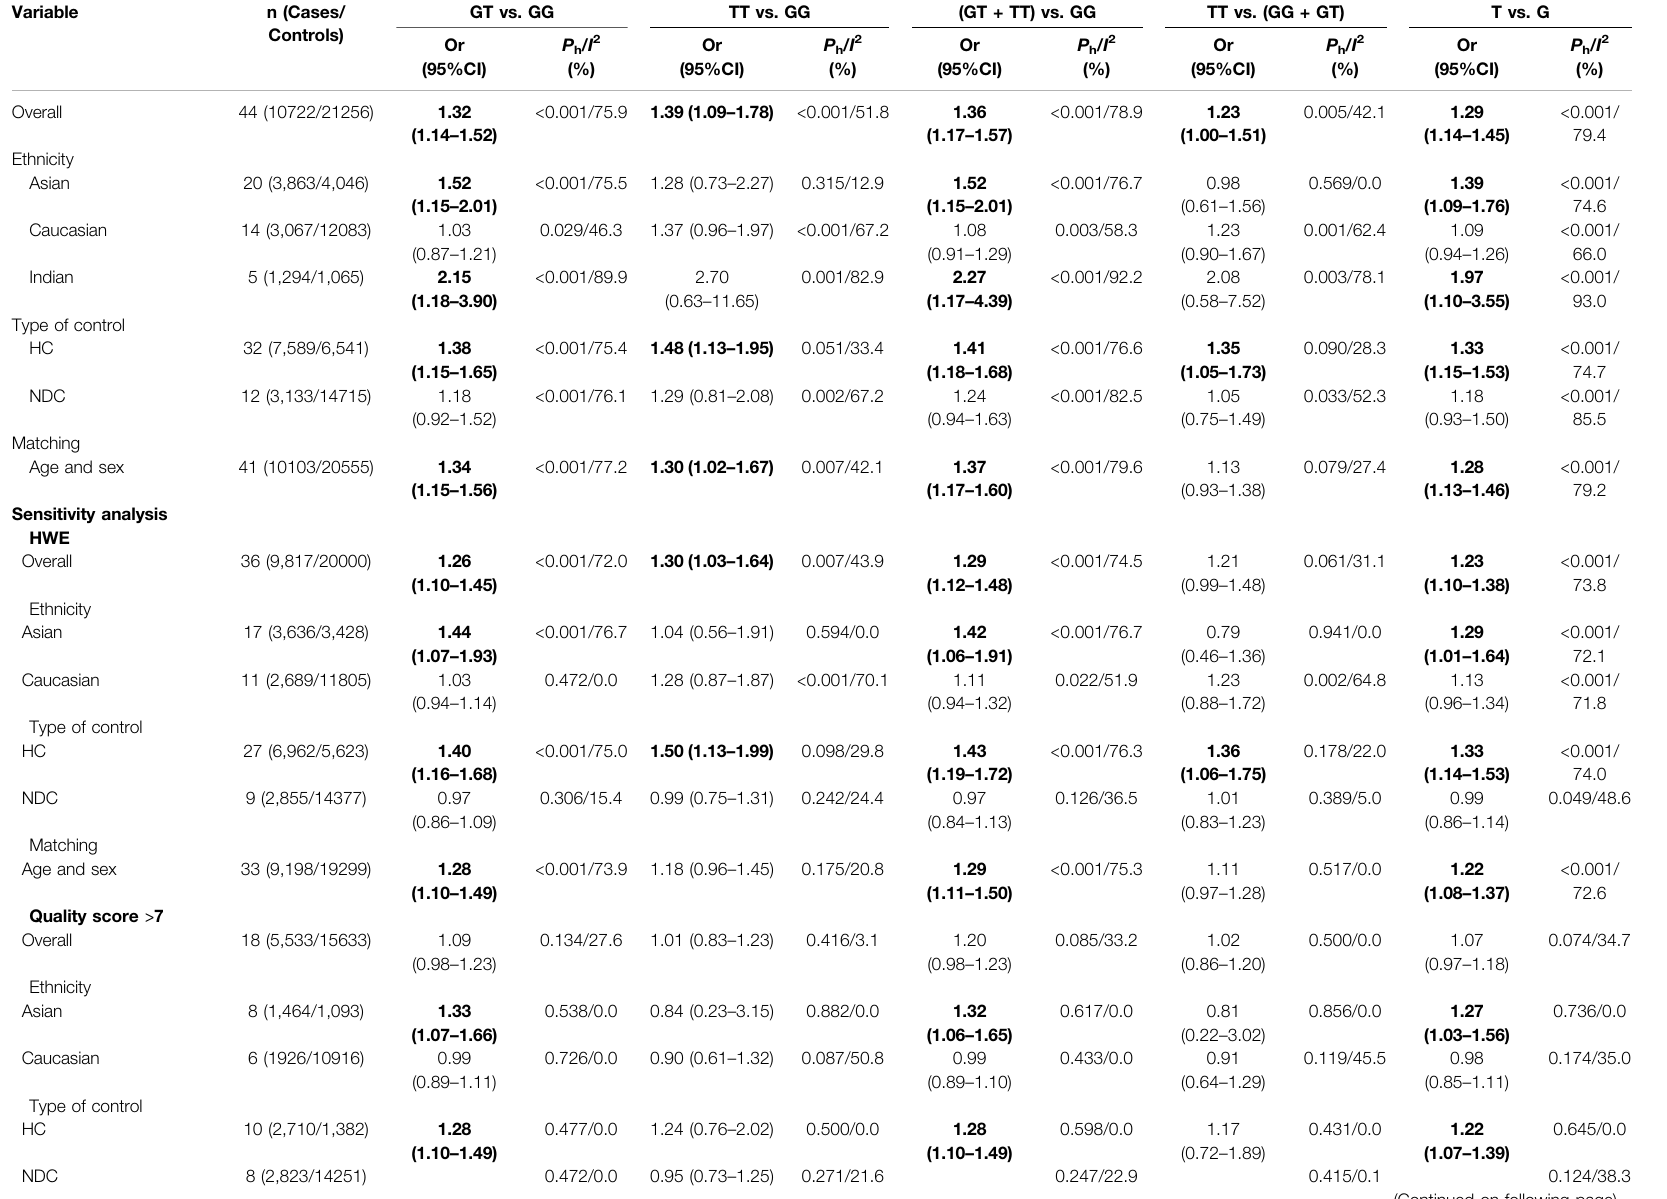
TABLE 7 | Meta-analysis of the association of eNOS G894T polymorphism with risk of T2DM.